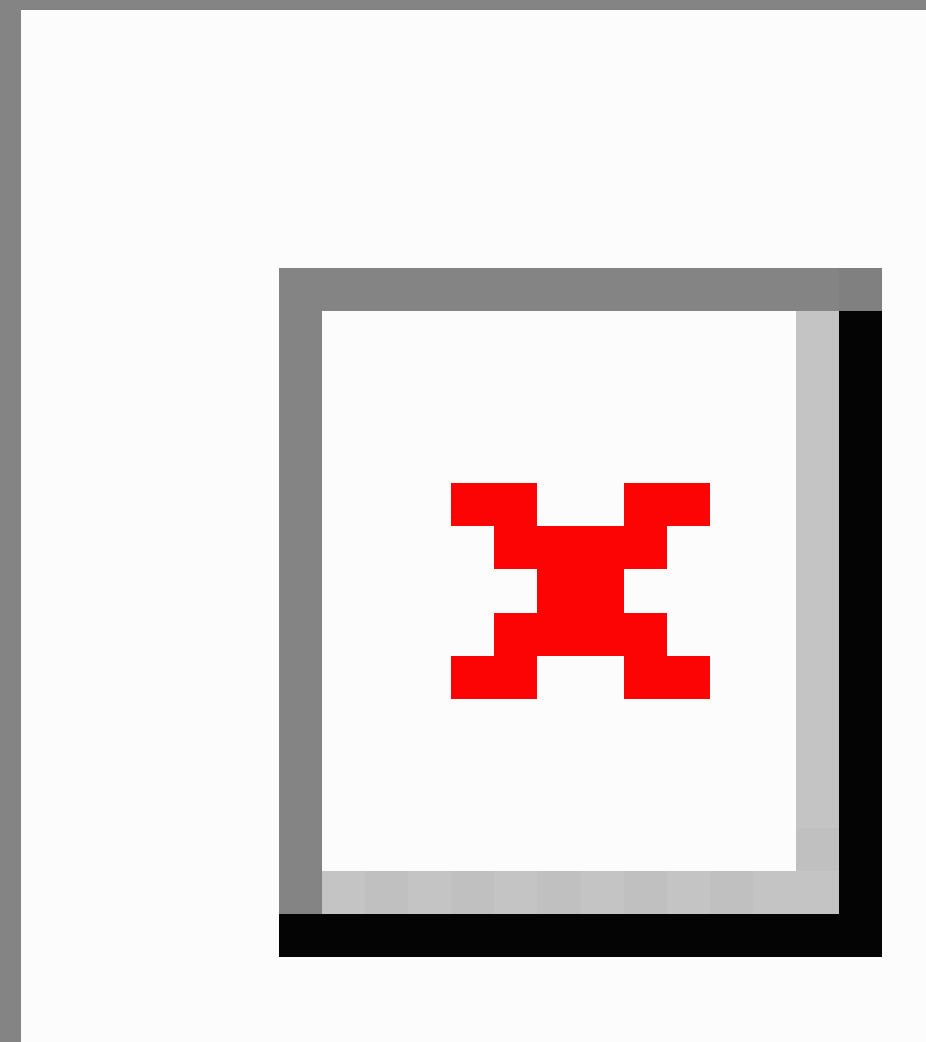
Figure 3. Flowchart of the clusters and